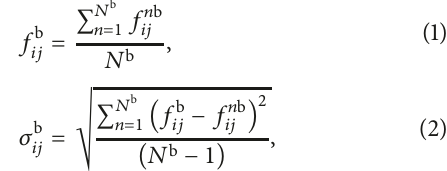
circle in the centre of the figure) is alleviated after the opening of Line 4. Several stations on other lines (highlighted in other red circles) share fewer passenger flows after the opening of Line 4. Thus, Line 4 attracts more individuals to metro network while contributing to the whole network by sharing a large number of passengers and reducing the crowding at several existing metro